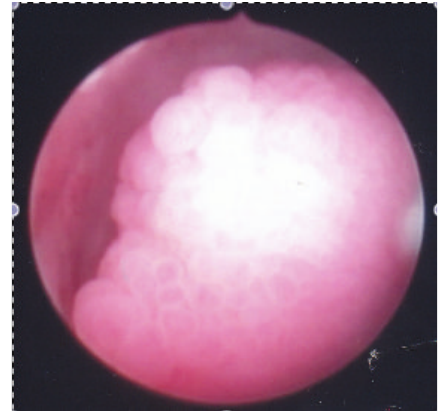
Figure 2: Diagnostic hysteroscopy: firm and pallid polyploidy mass containing multiple cystic spaces and some foci of hemorrhage.